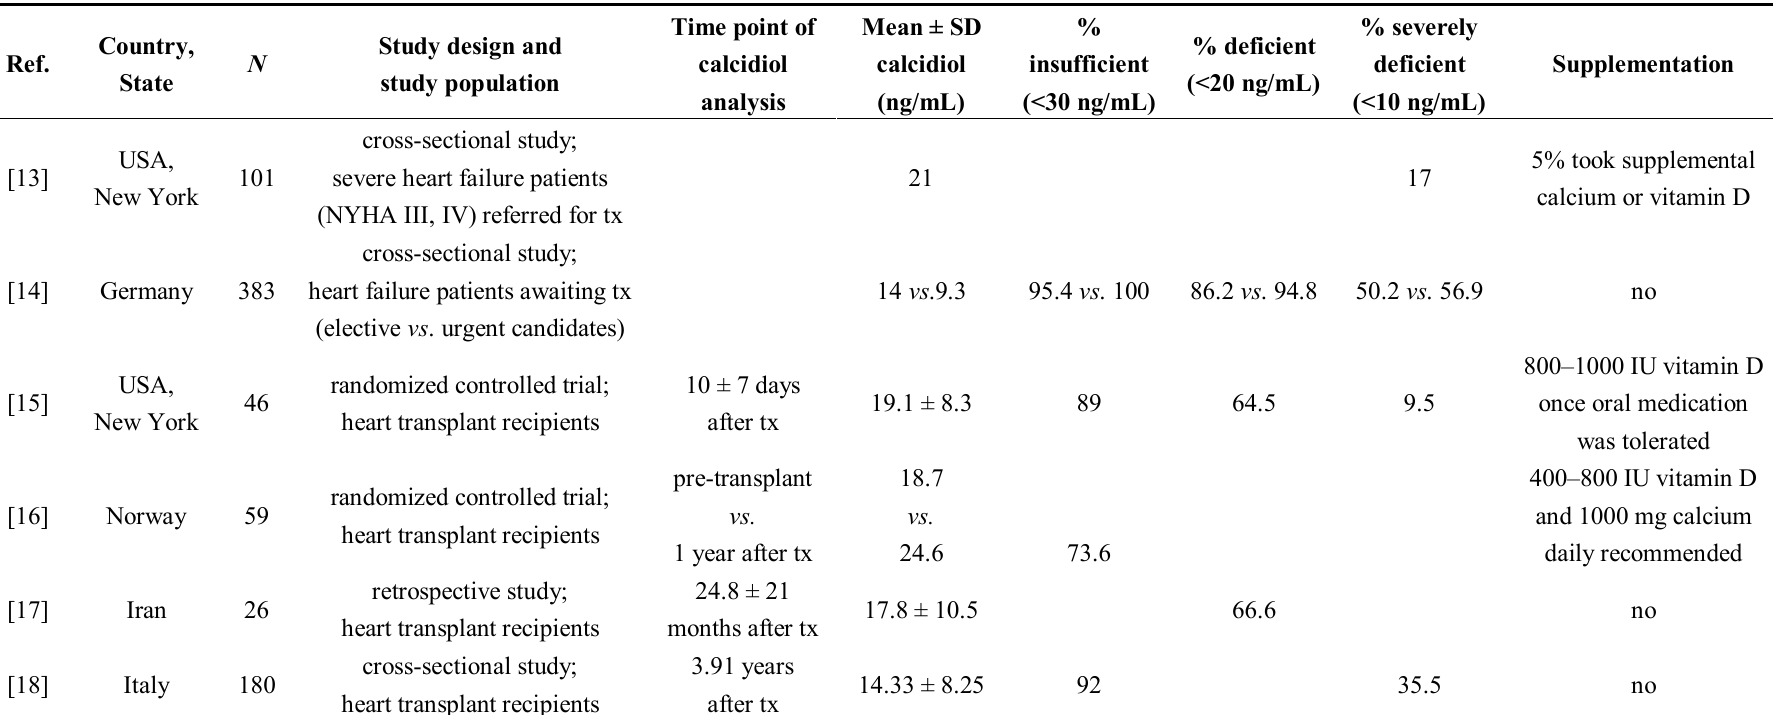
Table 1. Vitamin D status in congestive heart failure and cardiac transplant